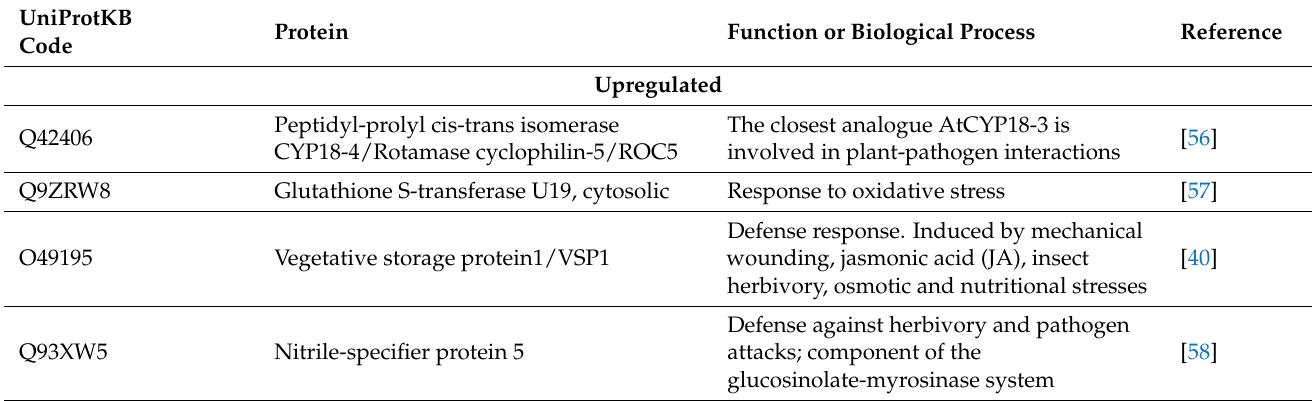
Table 3. RACK1A-interacting proteins which abundance was changed in rolB -plants, line